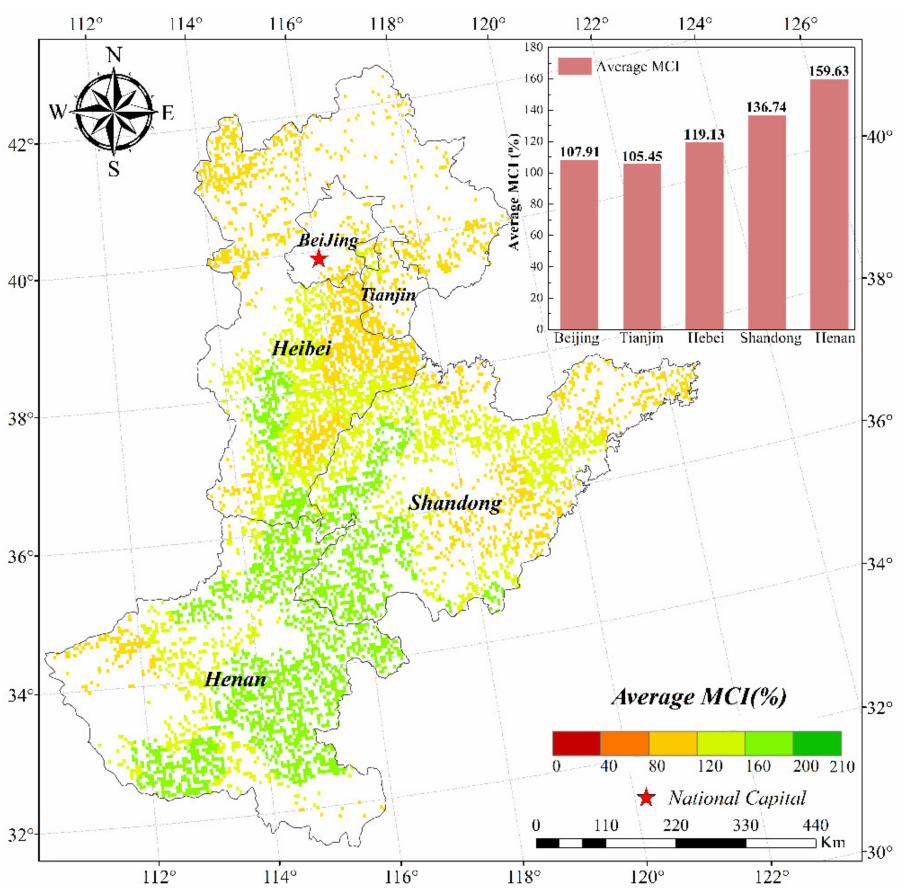
Figure 8. The distribution pattern of the average MCI of cultivated land from 1982 to 2018, which includes the distribution for the NCP from 1982 to 2018 and the average CI of cultivated land for the 5 provinces and cities in the study area from 1982 to